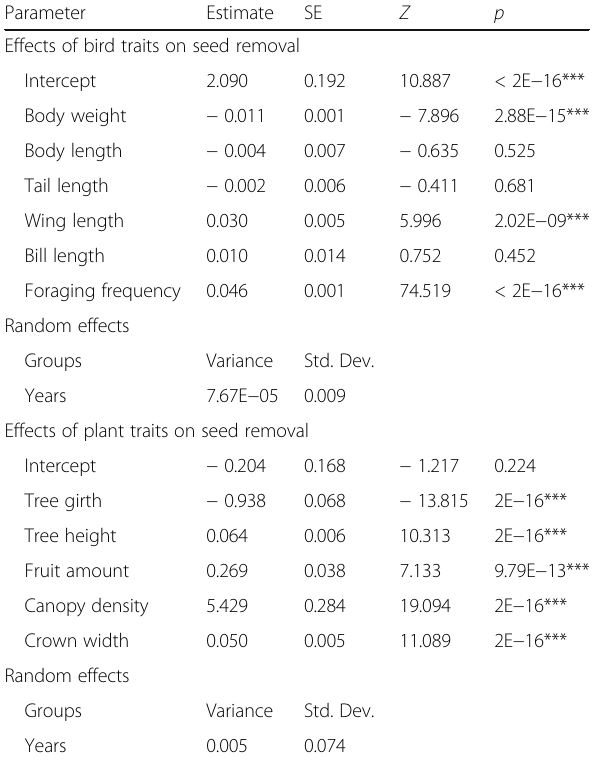
Table 3 Coefficients of generalised linear mixed-effects models with a Poisson distribution testing the effects of the factors of bird and plant traits on seed removal patterns of Taxus chinensis in the patchy forest of yew ecological garden, Fujian Province, southeast China